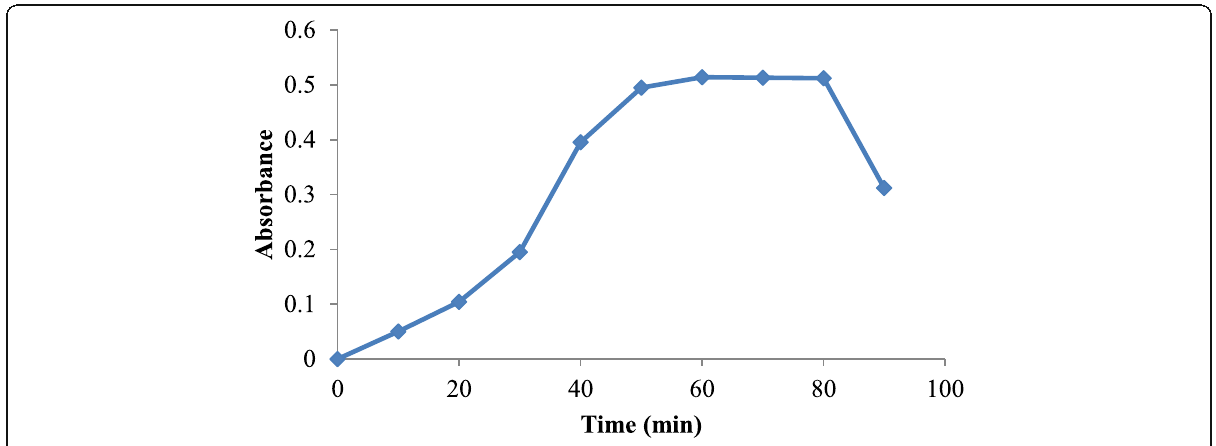
Fig. 4 Effect of time on the reaction